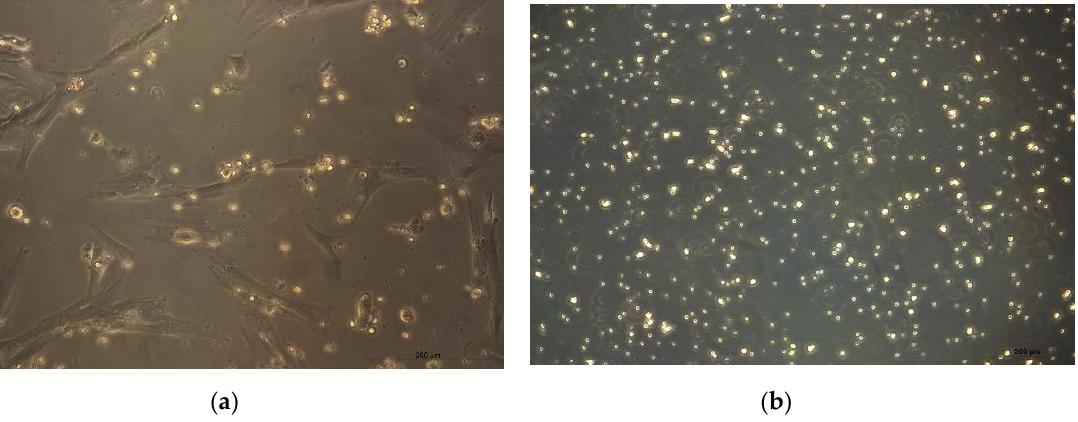
Figure 5. ( a ) CMSCs interact with lymphocytes in co-culture in vitro. CMSCs are adherent spindle shapes and lymphocytes have round shape (20× magnification of objective). ( b ) Activated PHA lymphocytes cultured separately (20× magnification of objective).